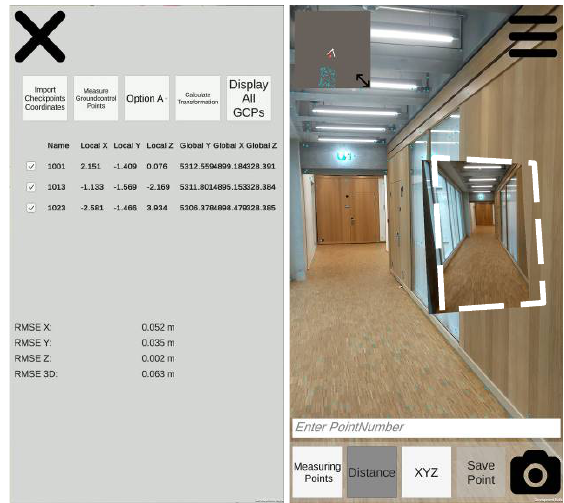
Figure 2. AR application: Display of 6DoF transformation residuals (left) and photo display with original pose (right, captured photo in dashed